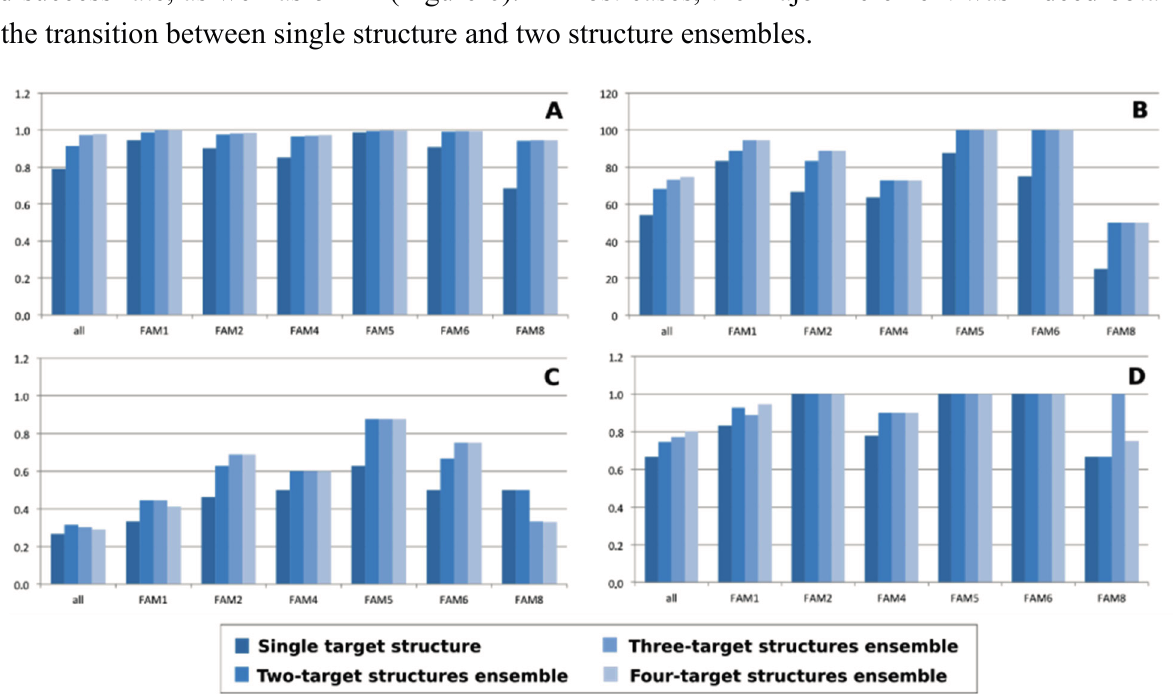
Figure 6. Variation of nAUC ( A ); %success ( B ) and enrichment factor at 1% ( C ) and 5% ( D ) as a function of the number of structures that compose the target